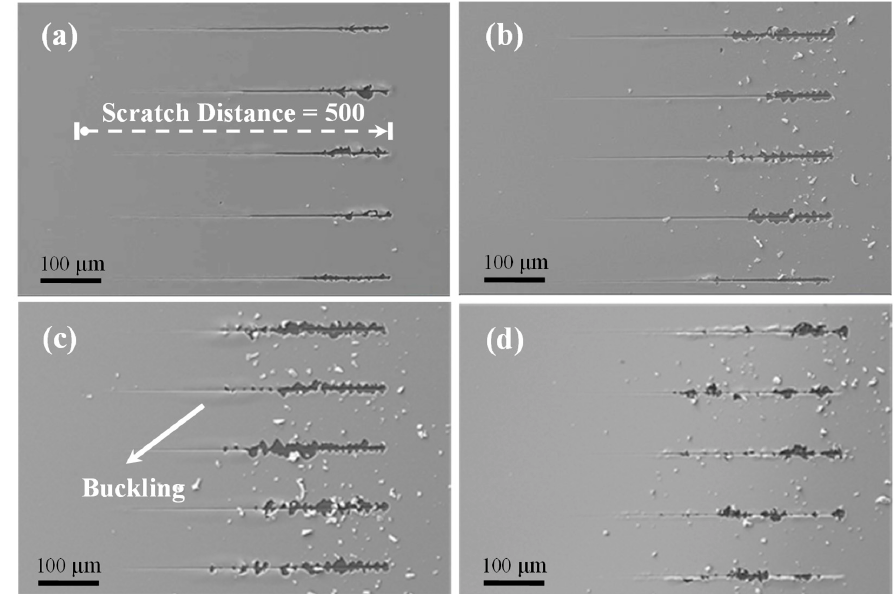
Figure 5. SEM images of the five scratch tracks performed on each of the ( a ) Mo-1, ( b ) Mo-2, ( c ) Mo-4, and ( d ) Mo-8 samples. The scratch tracks were explored from left to right in these SEM images to a maximal scratch distance of 500 μ m.